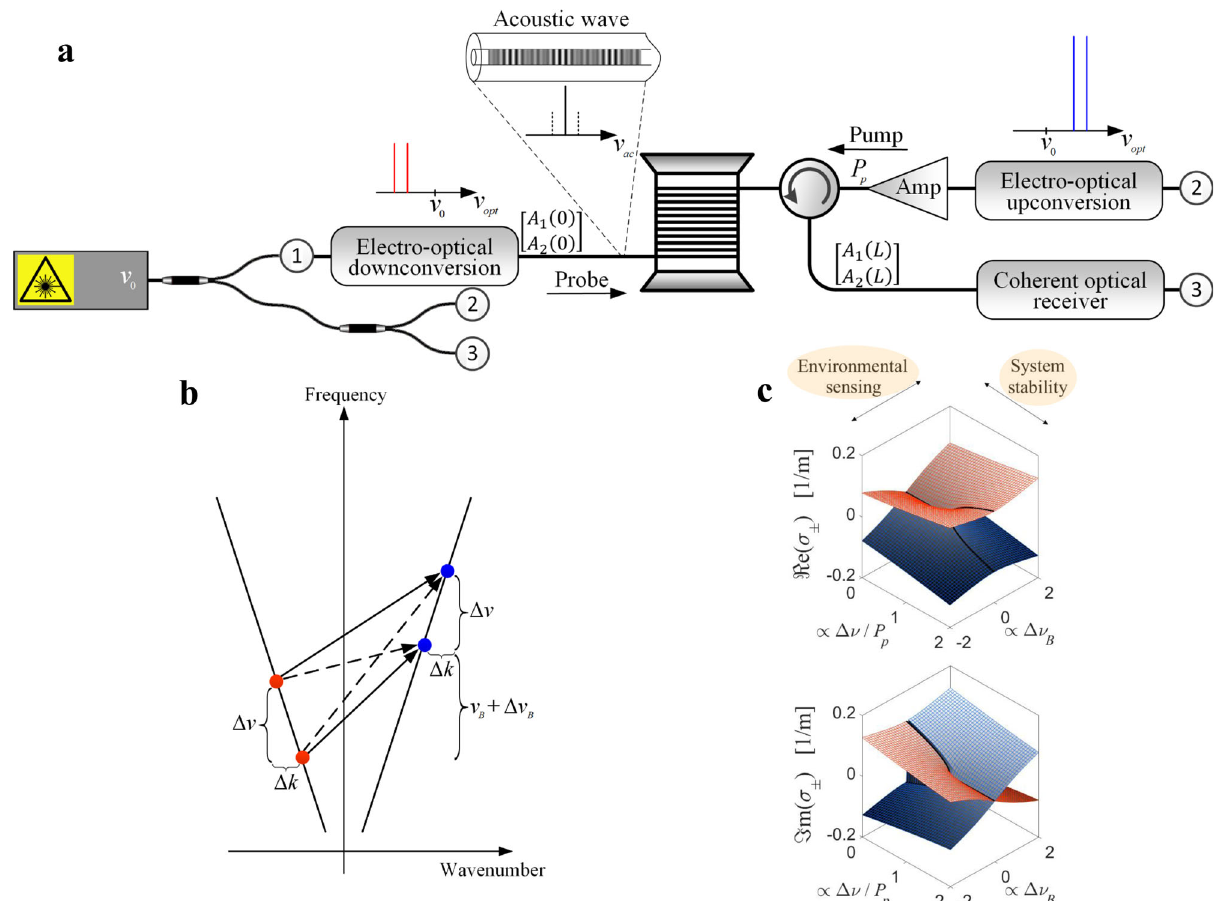
Fig. 1 Anti-PT-symmetric Brillouin-enhanced four-wave mixing process. a Schematic view of the fi bre platform at the basis of our experiments. All optical signals are synthesized from a single, narrow-band laser diode. Electro-optic modulation is used to prepare the input probe states, as well as the SBS pumps. Coherent detection fully recovers the output probe states. b Phase-matching diagram of the participating signals. Both resonant and off-resonant Brillouin interactions (solid and dotted black lines) take place in the fi bre. Off-resonance interactions are signi fi cant since the detuning Δ v is much smaller than the Brillouin linewidth. c Dependence of the probe eigenvalues σ ± on the system (ratio between frequency detuning Δ v and SBS pump power P p ) and environmental (manifested through changes in the Brillouin resonance frequency Δ v B ) conditions. The bold line refers to a system tuned to the SBS resonance ( Δ v B = 0), highlighting the transition from anti-PT-symmetric to a broken-symmetry regime, through the EP (see also experimental results in Fig. 2). Measurements of σ ± as a function of Δ v B in the vicinity of the EP are shown in Fig. 3 below, and the potential use in Brillouin sensing applications is discussed further in the